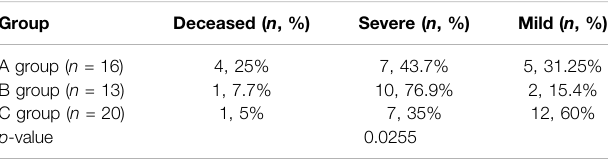
TABLE 4 | Analysis of the correlation between severity of disease and number of truncating variations patients carried.